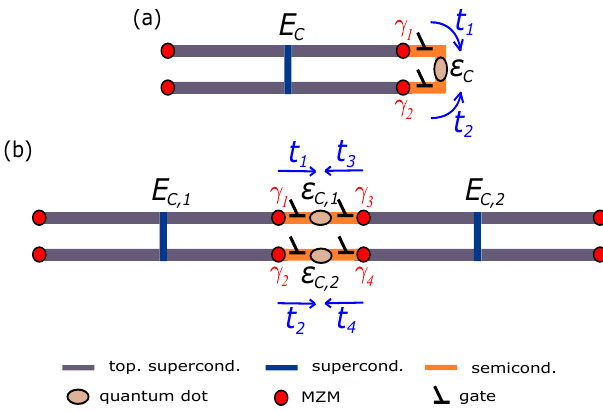
Figure 1: Schematic of the measurement setup of multi-MZM qubit islands. Only the measured MZMs of the qubit are labeled. (a) 2-MZM (single qubit) measurement setup. (b) 4-MZM (two qubit) measurement